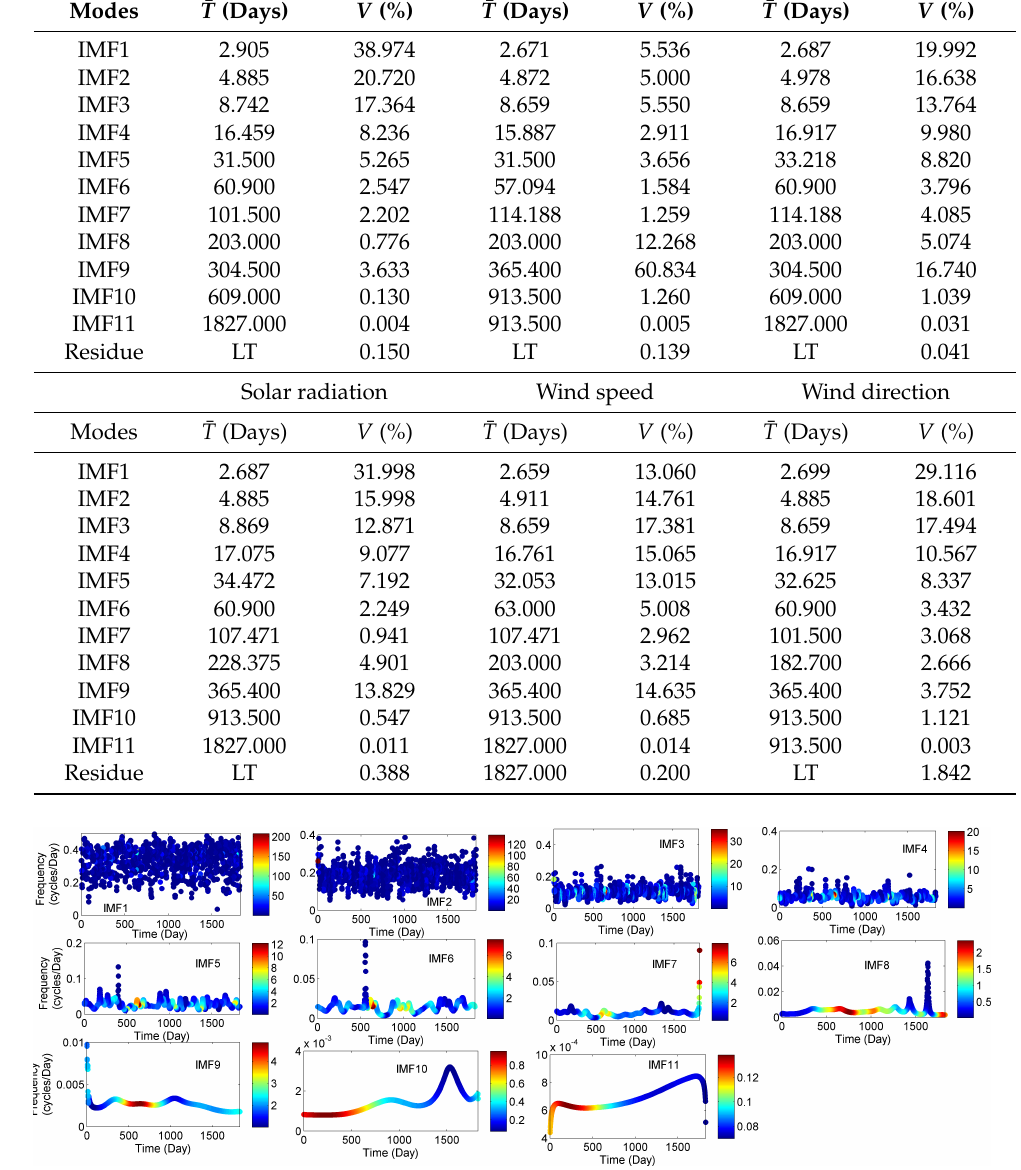
Figure 5. The time-Frequency -frequency-amplitude spectra of IMFs of